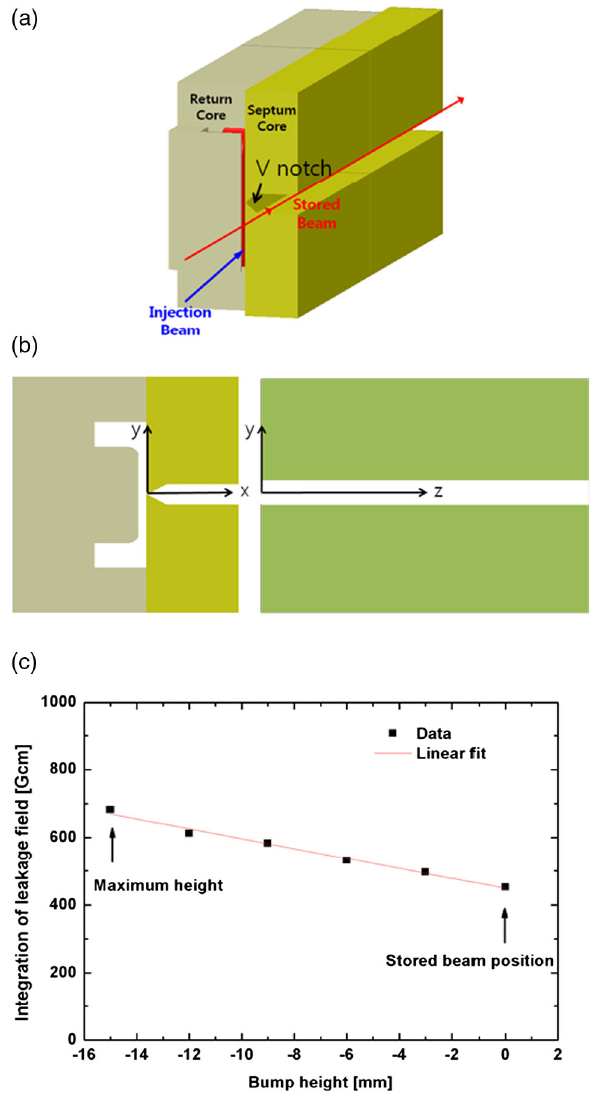
FIG. 1. (a) Model of the Lambertson septum magnet. (b) Def- inition of coordinates along the septum magnet. (c) Integrated leakage field along the bump height ( x